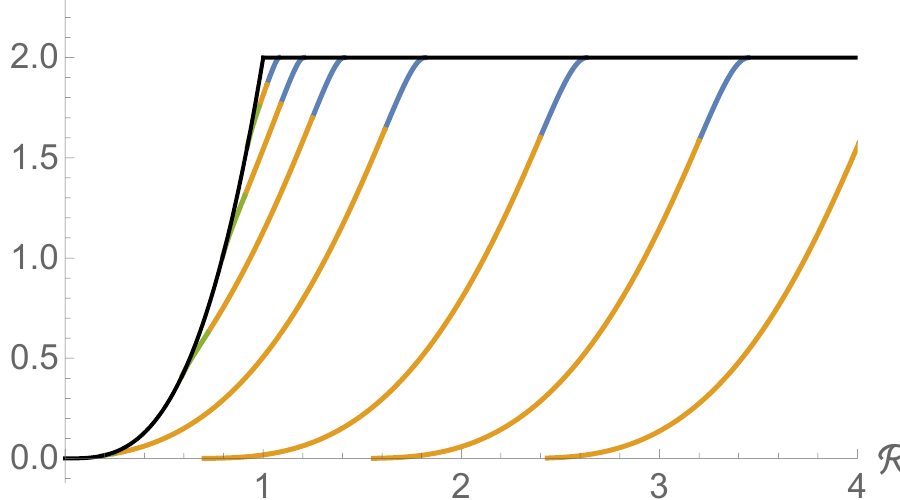
Figure 14. Mutual information from the two-sided extremal scaling surface for the d = 4 Schwarzschild black brane. The black line shows the contribution of the surfaces determined by (5.13), and it gives the t=R L = = 0 value of ( ). The other times plotted are T I R = 1 = 10 ; 1 = 4 ; 1 = 2 ; 1 ; 2 ; 3 ; 4, di(cid:11)erent colors denote the cases (a), (b), and (c), as in (cid:12)gure 13. T E.g. the = 1 = 10 curve is obtained by (cid:12)rst going along the black line, then cutting the corner T with the colored curve, and then continuing with the black line, while the = 4 curve starts as 0, T and gets up to the (black) saturation value on an orange and blue curve.